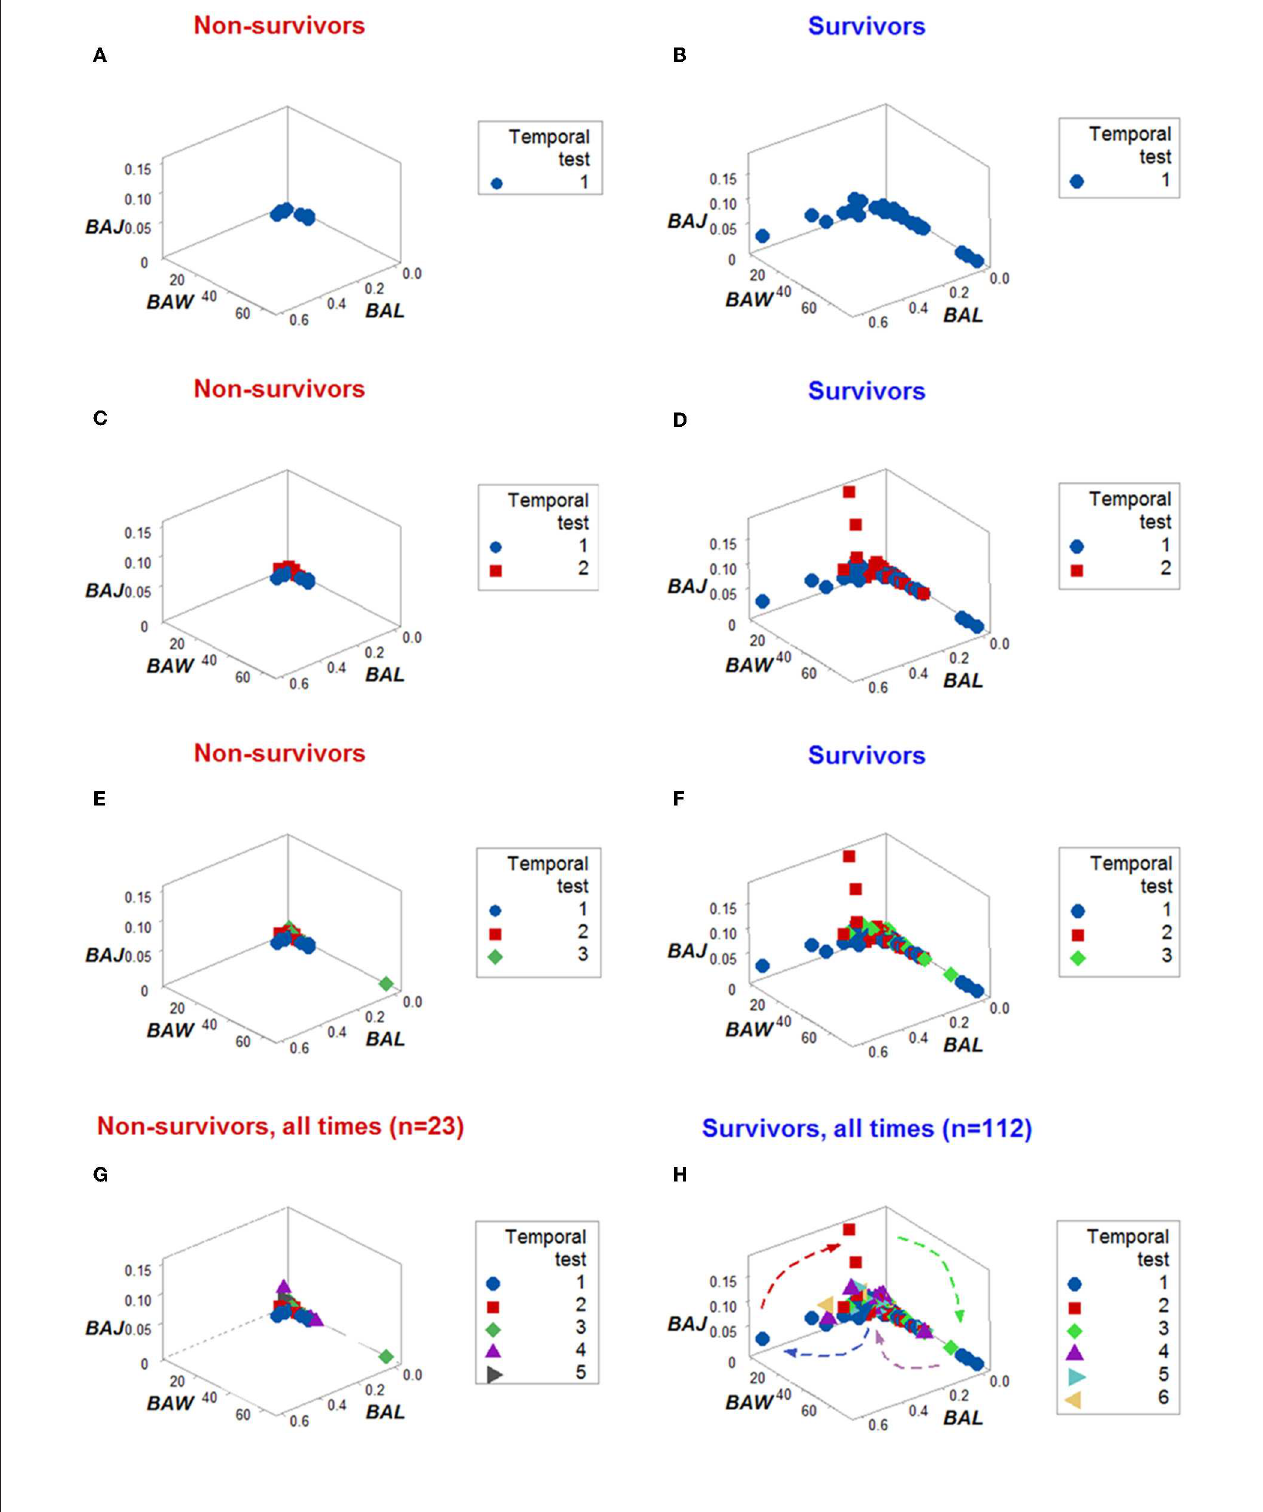
FIGURE 5 | Dynamic pattern-related prognostics (I): survivors. When only the temporal order –not the actual dates– in which patients were tested was plotted, the spatial-temporal patterns created by the directionality of the data distinguished non-survivors (A,C,E,G) from survivors (B,D,F,H) .